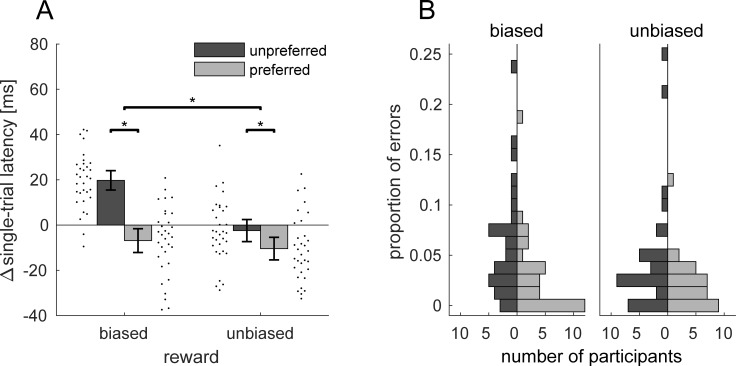
Single-trial behavior.Single-trial latencies (A) and errors (B) for preferred (light) and unpreferred (dark) targets. (A) Single-trial latencies in every condition are expressed as the difference from the individual mean. Black dots next to each bar graph denote values of individual participants in that respective condition. Error bars denote 95% confidence intervals of between-participant variability. Asterisks indicate significant (p < 0.05) comparisons. (B) vertical histogram of the proportion of single-trial errors.